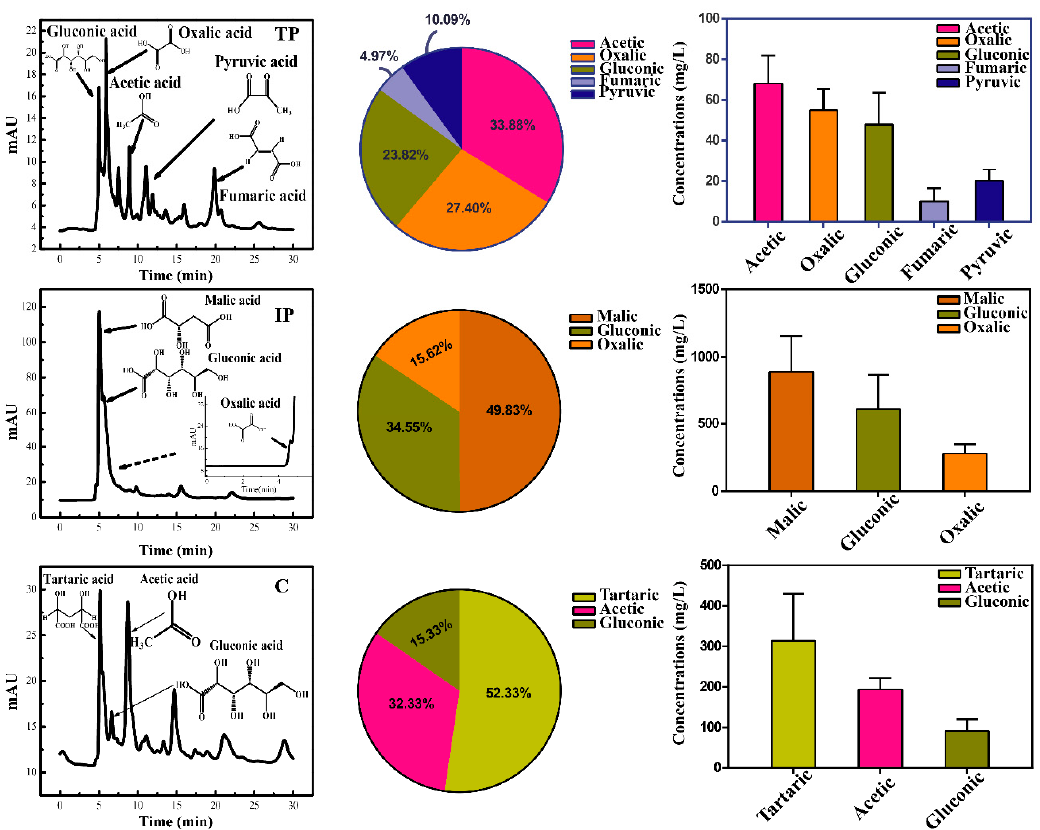
Figure 2. High-performance liquid chromatography (HPLC) diagrams for low-molecular-weight organic acids (LMWOAs) secreted by P. oxalicum cultivated with tricalcium phosphate (TP), iron phosphate (IP), and dipotassium phosphate (C) after three days of cultivation during P solubilization.